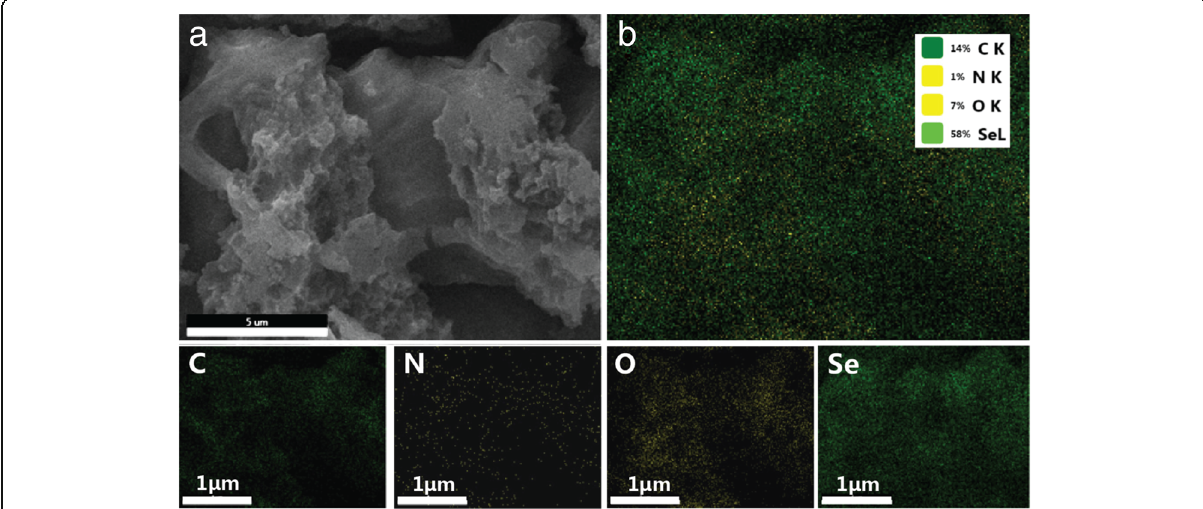
Fig. 3 a FESEM images of the Se-R800A. b Elemental mapping images of C, N, O, and Se of the Se-R800A and the corresponding EDX